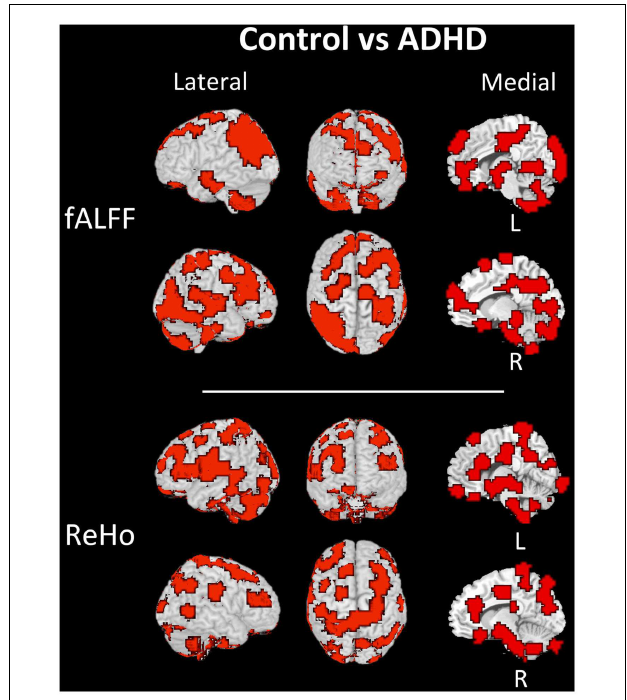
FIGURE 4 | Brain mapping of 5% regions containing most discriminative information in control vs.ADHD patients classification when using fALFF + REHO